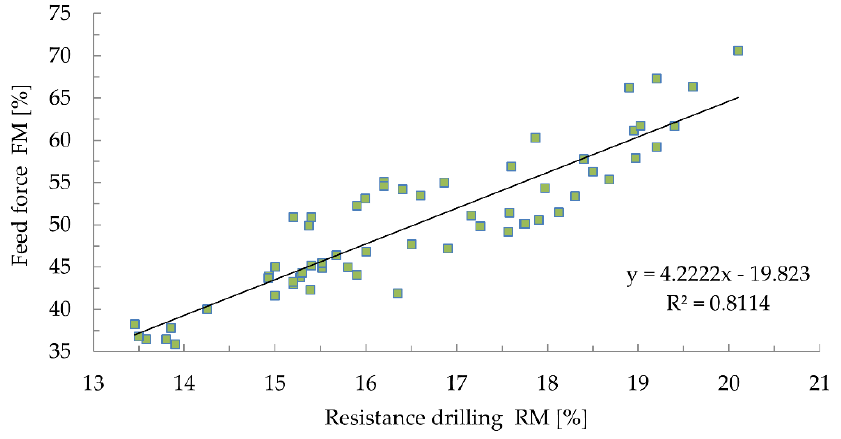
Figure 8. Correlation between drilling resistance and feed force.